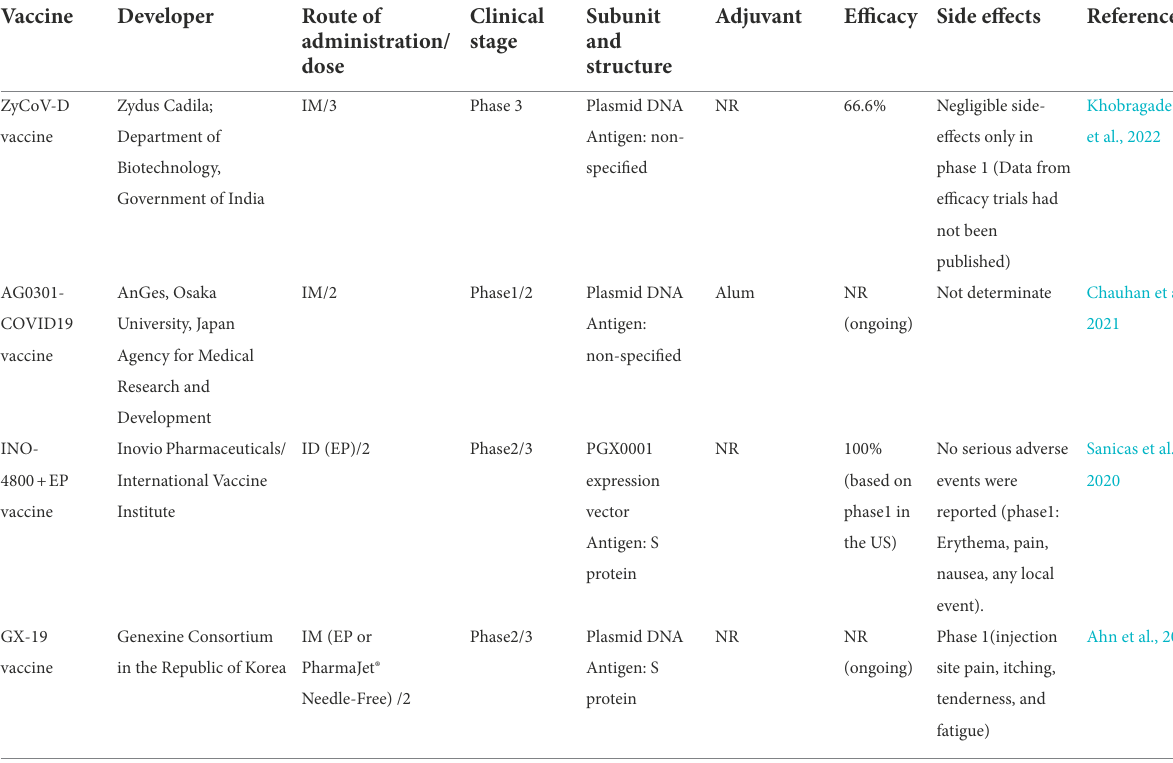
TABLE 1 Characteristics of COVID-19 DNA